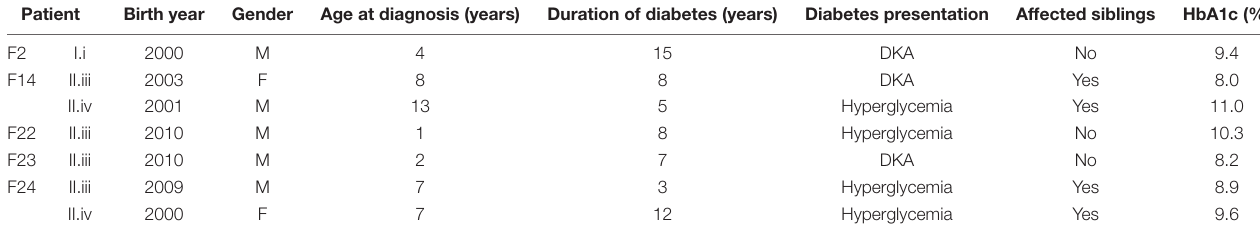
TABLE 1 | Clinical data on the T1D subjects of this